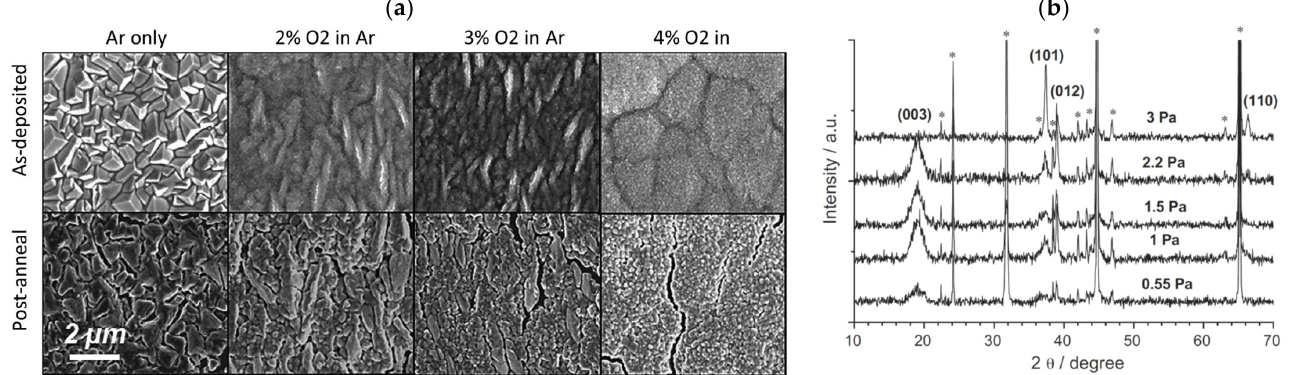
Figure 4. ( a ) SEM images of 10 μ m thick LCO films on Au-coated Al substrate fabricated under different atmosphere and annealing condition. Reproduced with permission [56]. Copyright 2017, Elsevier. XRD patterns of ( b ) LCO films deposited at different working gas pressure. * means substrate peaks. Reproduced with permission [57]. Copyright 2012, Elsevier.